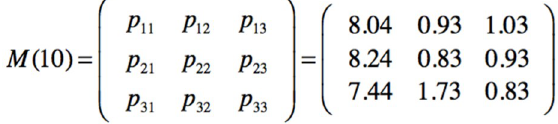
Figure 28. Number of visits for the posterior transition matrix.